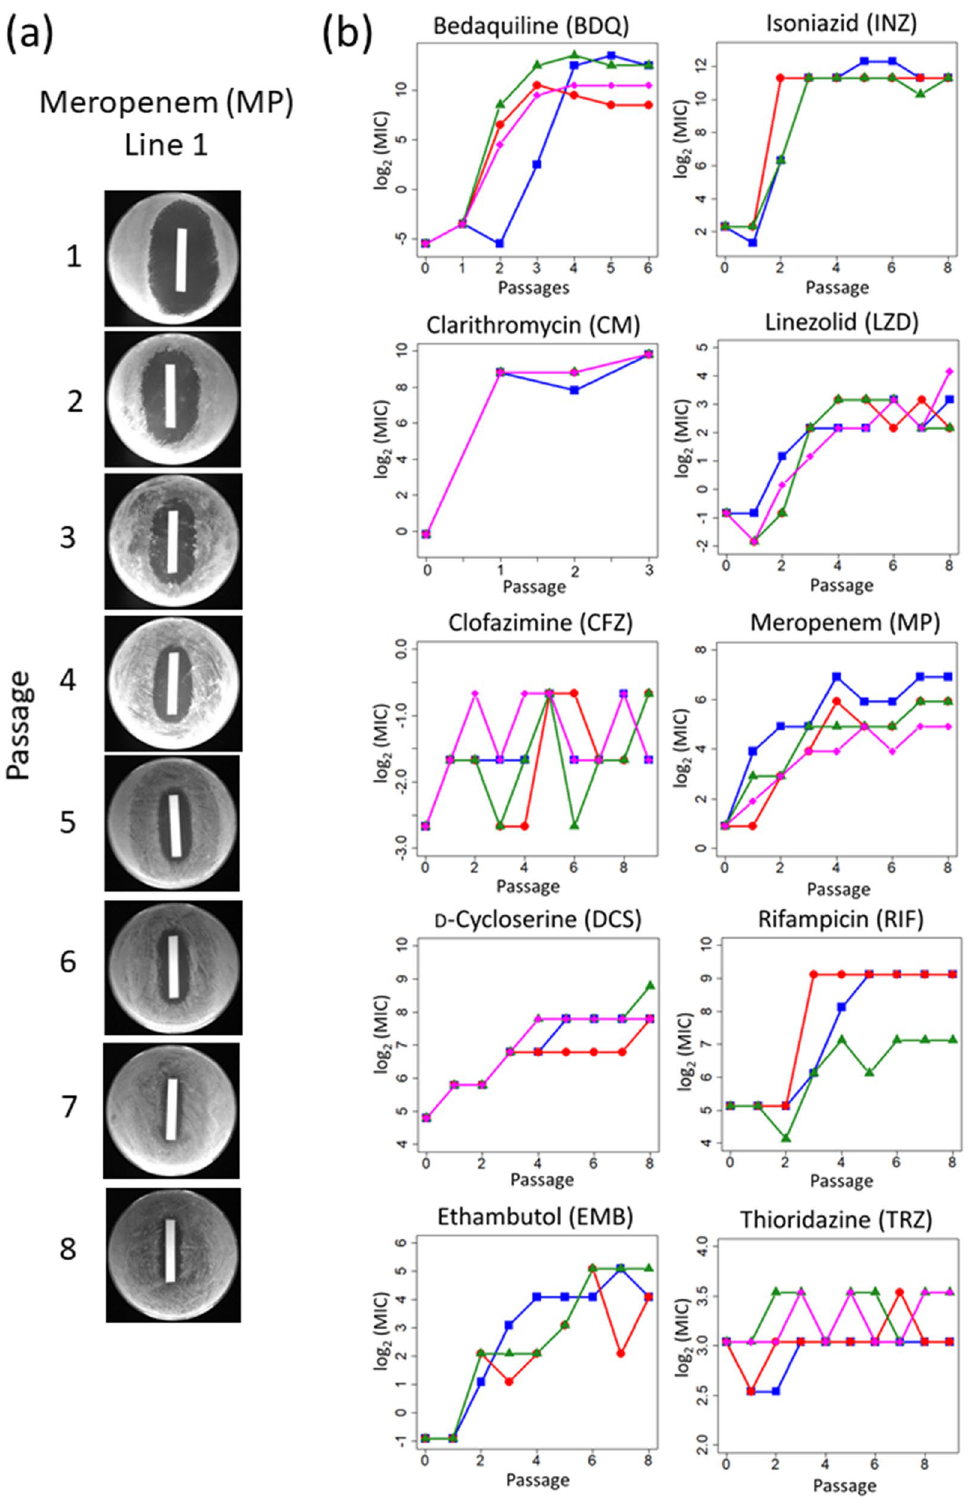
Figure 2. Resistance time series for laboratory evolution. ( a ) Representative images of the culture plates from the laboratory evolution experiment. The images of MP-evolved line 1 are shown. The filter papers were soaked in 10 mg ml −1 MP. ( b ) Time series of minimum inhibitory concentrations (MIC) calculation during the laboratory evolution experiment. The MIC values (log 2 (MIC [μg ml −1 ]) of three or four independent culture lines (line 1: blue, line 2: red, line 3: green, and line 4: magenta) are